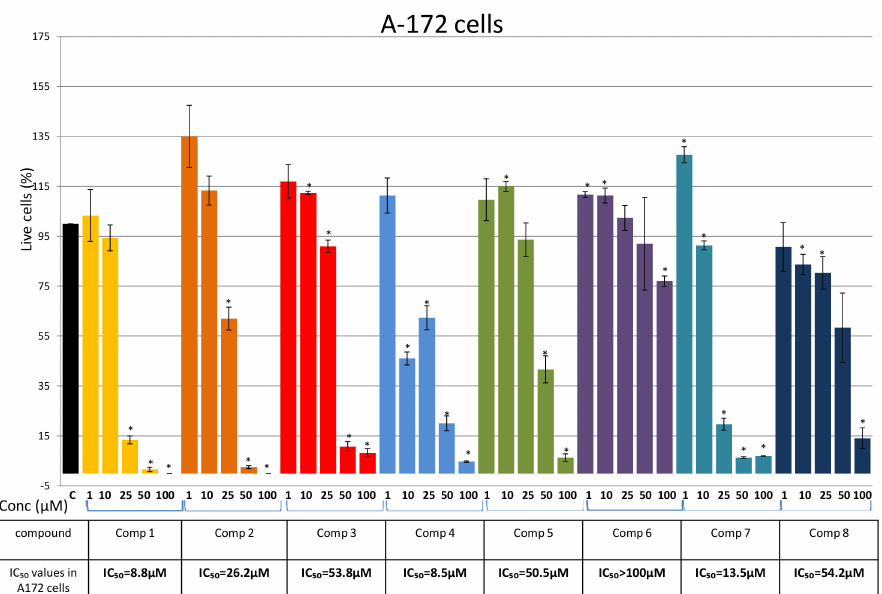
Figure 7. Effects of Compounds 1–8 on A-172 cells. Cells were treated for 48 h with increasing concentrations (1 µ M, 10 µ M, 25 µ M, 50 µ M, and 100 µ M) of the tested compounds and cell viability was assessed using an MTT assay and expressed as the percentage of absorbance relative to the vehicle control (A-172 cells treated with DMSO), which was set at 100%. Data are presented as the mean ± SEM of at least three independent experiments. An asterisk denotes a significant difference from the control (* p < 0.05). SEM—standard error of the